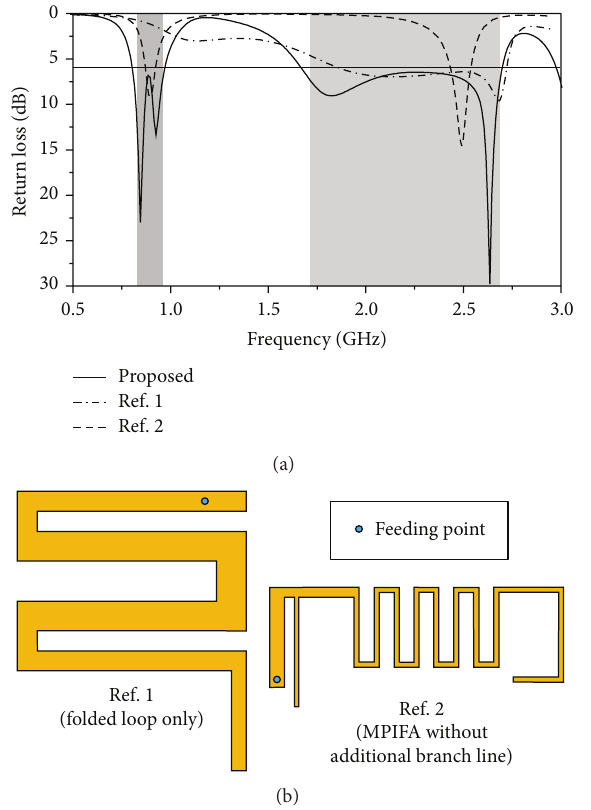
Figure 2: Simulated return loss characteristics of the proposed antennaforthefolded-looponlycase(Ref.1)andforMPIFAwithout an additional branch line (Ref. 2) case. The dimensions of these reference antennas are shown in Figure 1.